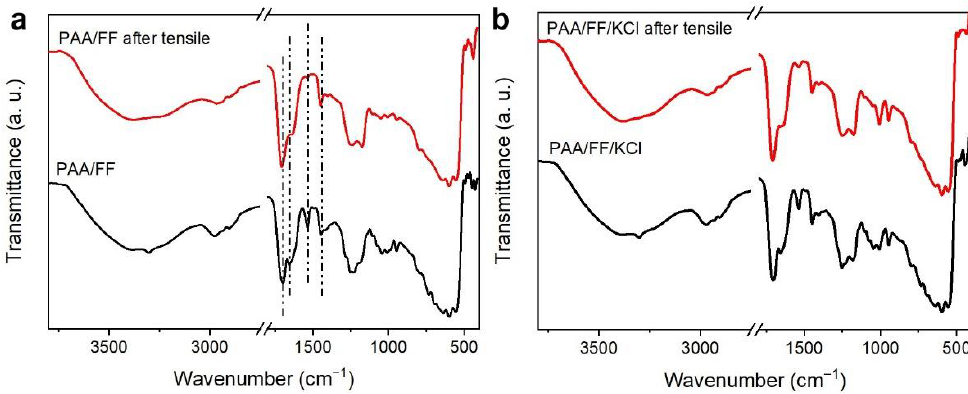
Figure 3. The FTIR spectra of ( a ) the original PAA/FF gel and of that after the final stretch break, and those of ( b ) the PAA/FF and PAA/FF/KCl gels.